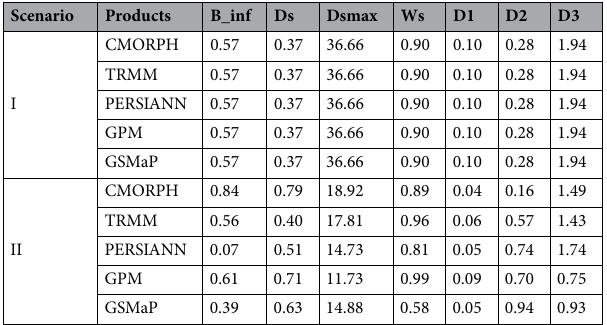
(Table 3, Fig. 6). The PERSIANN-based runoff simulation systematically overestimated most of the streamflow series, with NSE of − 1.057 and RE of 71.8%. The GSMaP overestimated the streamflow by 3.1% from 2003 to 2015, probably due to the cancellation of precipitation bias in different periods. We found an underestimation before 2011 and an overestimation after it. The streamflow driven by TRMM exhibited satisfactory results with the NSE of 0.710 and RE of 11.0%, respectively (Table 3, Fig. 6). The streamflow driven by CMORPH had a trend of underestimation before 2007 but showed comparable quality with observations after that, resulting in with the corresponding satellite precipitation dataset in Scenario II. The calibration and validation periods were the same as that of Scenario I. Figure 6 showed the observed and simulated streamflow comparisons. The simulation performances from the three SPPs (TRMM, CMORPH, GSMaP) had improved after the individu- ally calibrating, whereas the simulation from PERSIANN and GPM had minor changes. The simulation from the GPM had daily NSE of 0.86 and 0.82, and daily RE of − 19.6% and − 13.4% for the calibration and validation period, respectively, showing great potential in the hydrologic utility. The simulation from PERSIANN exhibited